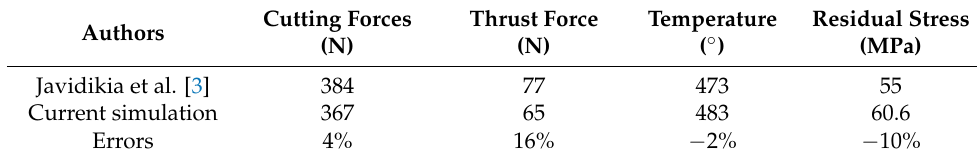
Table 5. Comparison of simulated results and experimental data obtained by Javidikia et al. [3]. V = 950 mm/min, f = 0.16 mm/min, rake angle 17.5 ◦ , and clearance angle 7 ◦